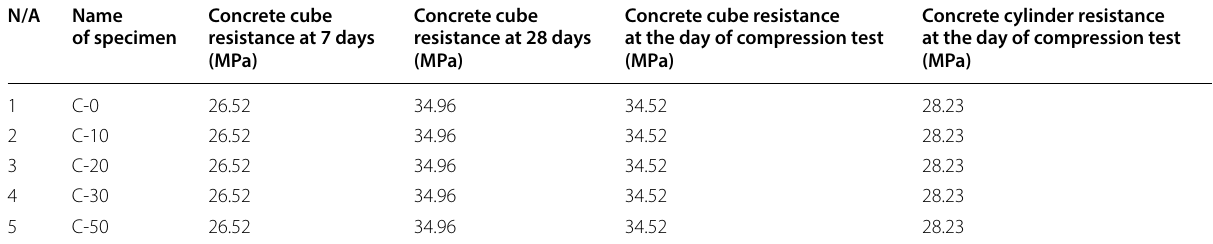
Table 2 Concrete mechanical properties.